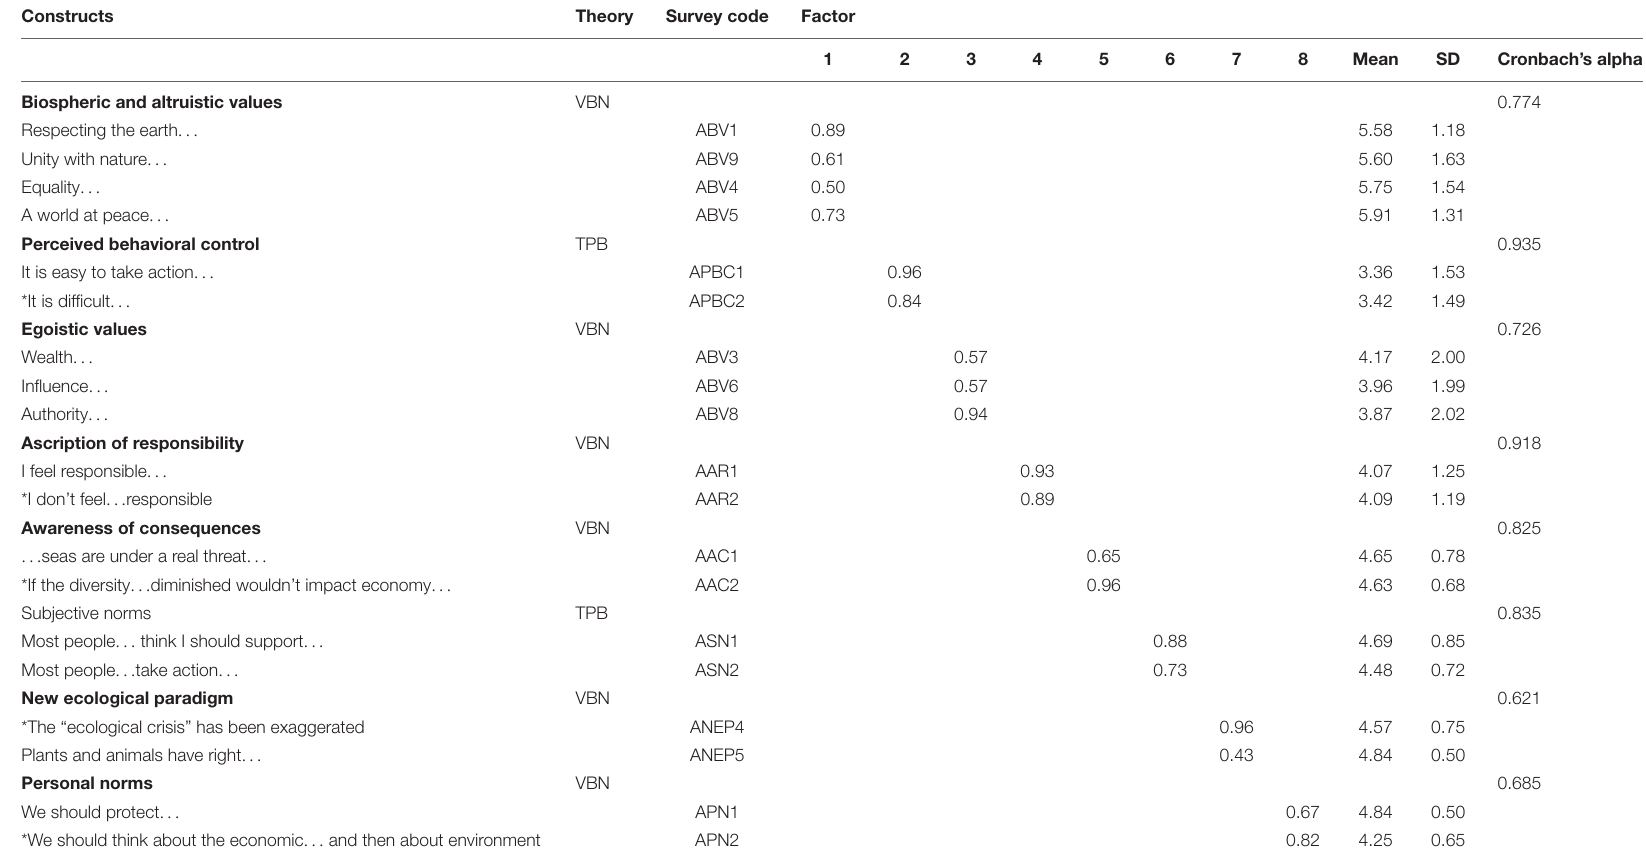
TABLE 2 | Factor analysis on values, beliefs, and norms regarding restoration of high-trophic level species and sustainable fisheries in the Gulf of Nicoya and reliability estimates for each extracted factor (post-survey sample).